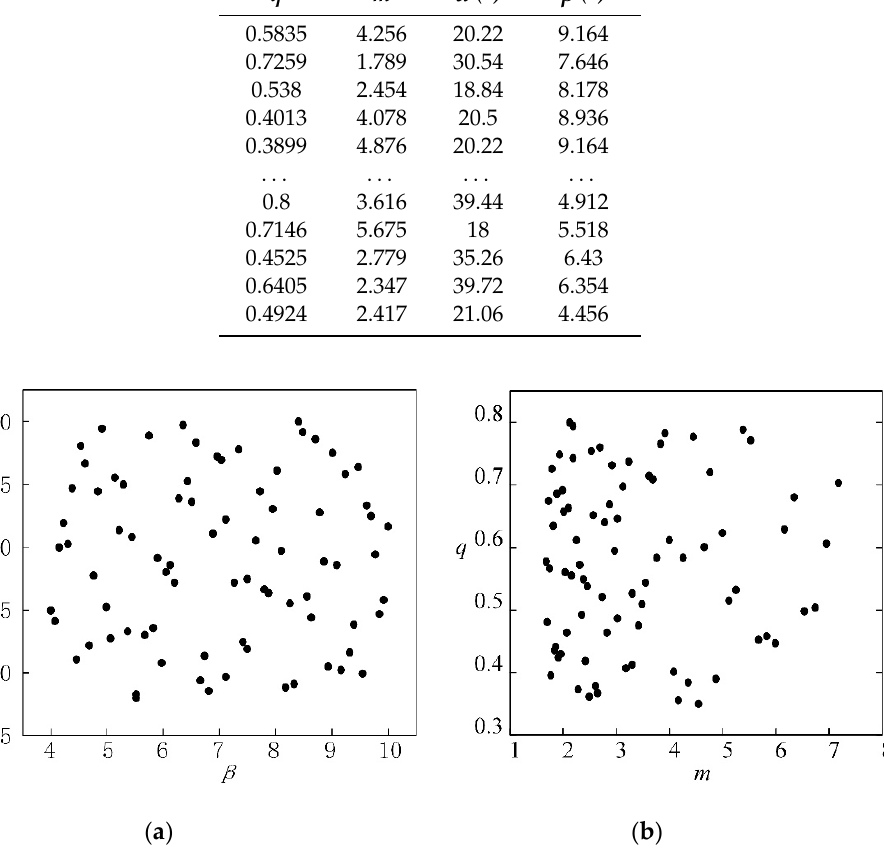
Figure 6. Distribution of different sampling points. ( a ) α and β ; ( b ) q and m .